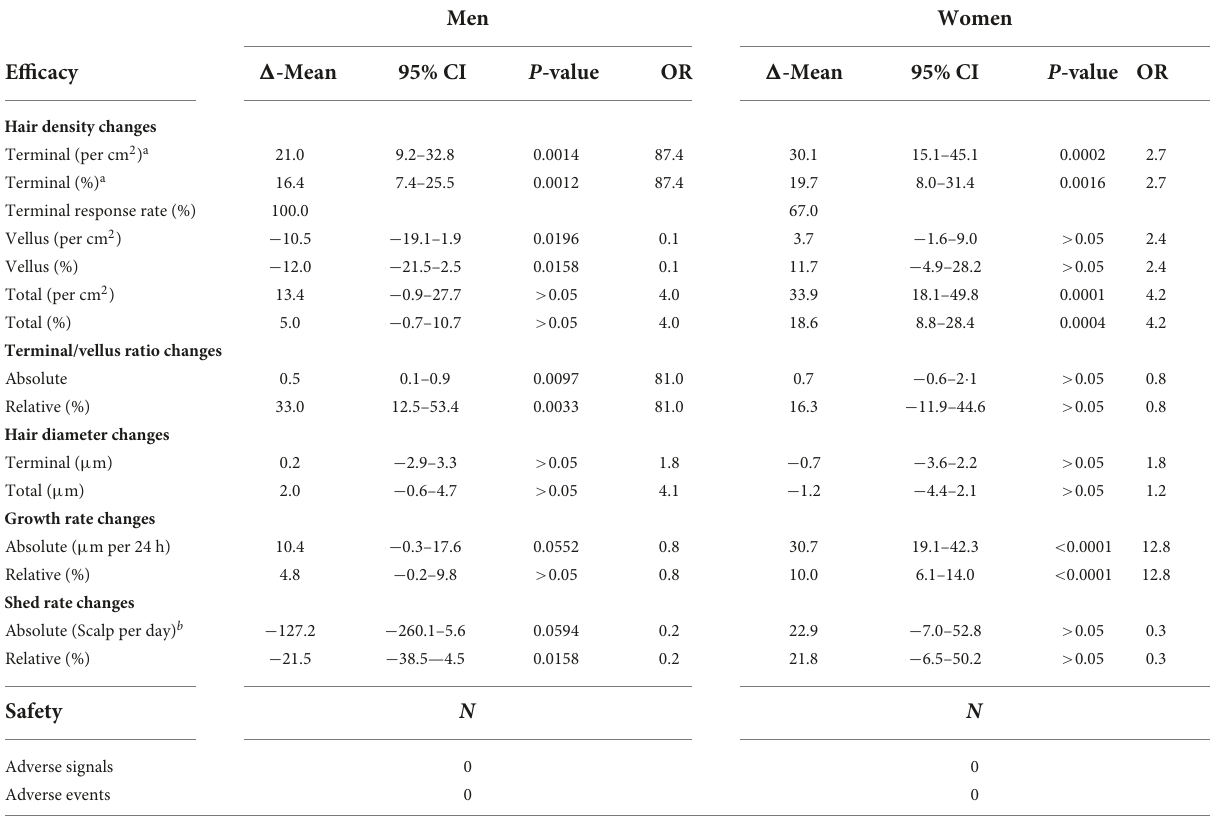
TABLE 1 Summary of results after 24 weeks. Summary of efficacy results after 24 weeks of treatment between ALRV5XR and